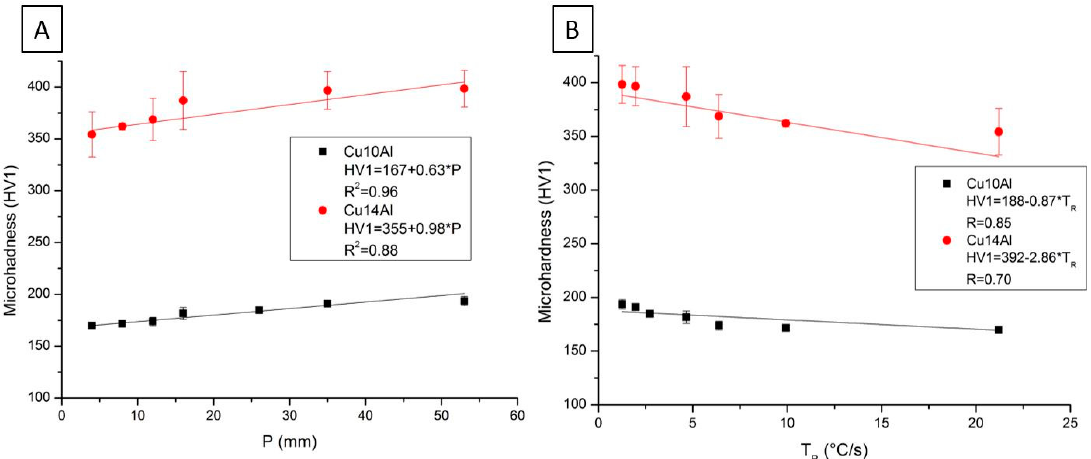
Figure 6. ( A ) Correlation between microhardness (HV1) and distance from heat extraction surface (P); and ( B ) correlation between microhardness (HV1) and cooling rate (T R ). The error bars represent the standard deviation of the measurements obtained.